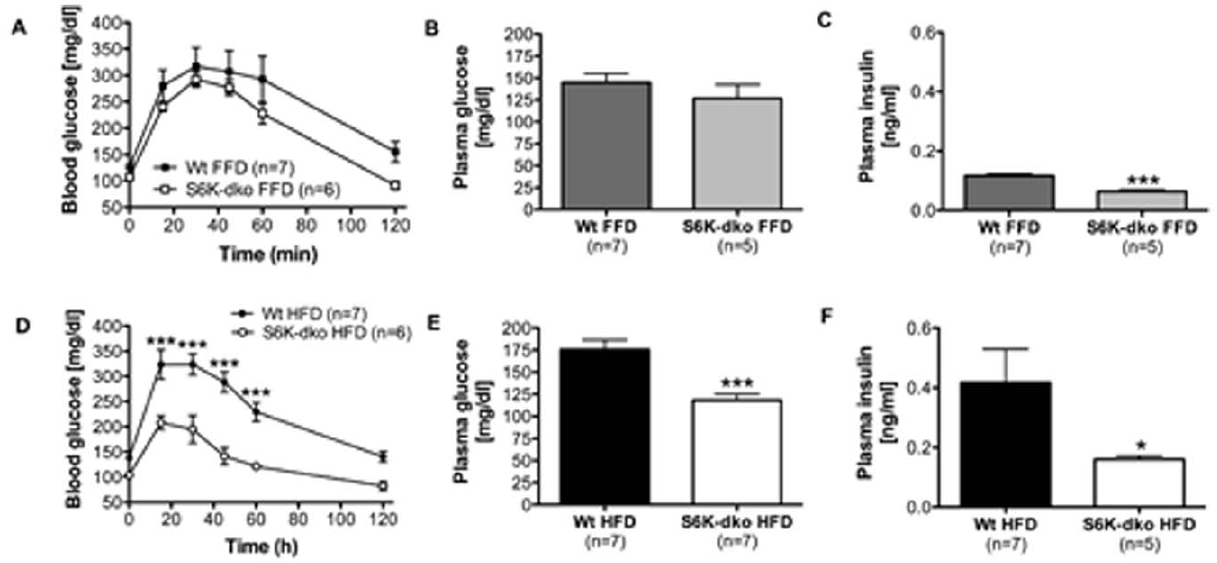
Figure 6. S6K-dko glucose tolerance and diet. S6K-dko mice fed a high-fat diet have significantly higher glucose tolerance (D) and lower plasma glucose (E) and insulin (F) compared to wt controls. When fed a fat-free diet, S6K-dko mice do not show better glucose tolerance (A) or lower plasma glucose levels (B) in spite of having significantly lower plasma insulin levels (C). FFD, fat-free diet; HFD, high-fat diet. One-tailed t test * P , 0.05, two- tailed t test *** P , 0.001 and two-way ANOVA *** P , 0.001.